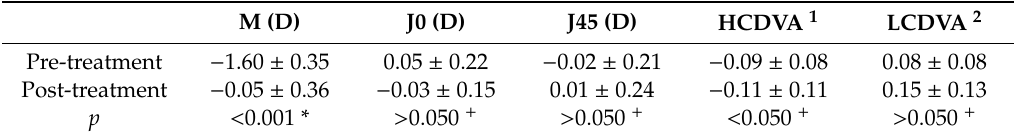
Table 1. Descriptive Statistics (Mean ± SD) for Population Data Collection of refractive error and visual acuity.